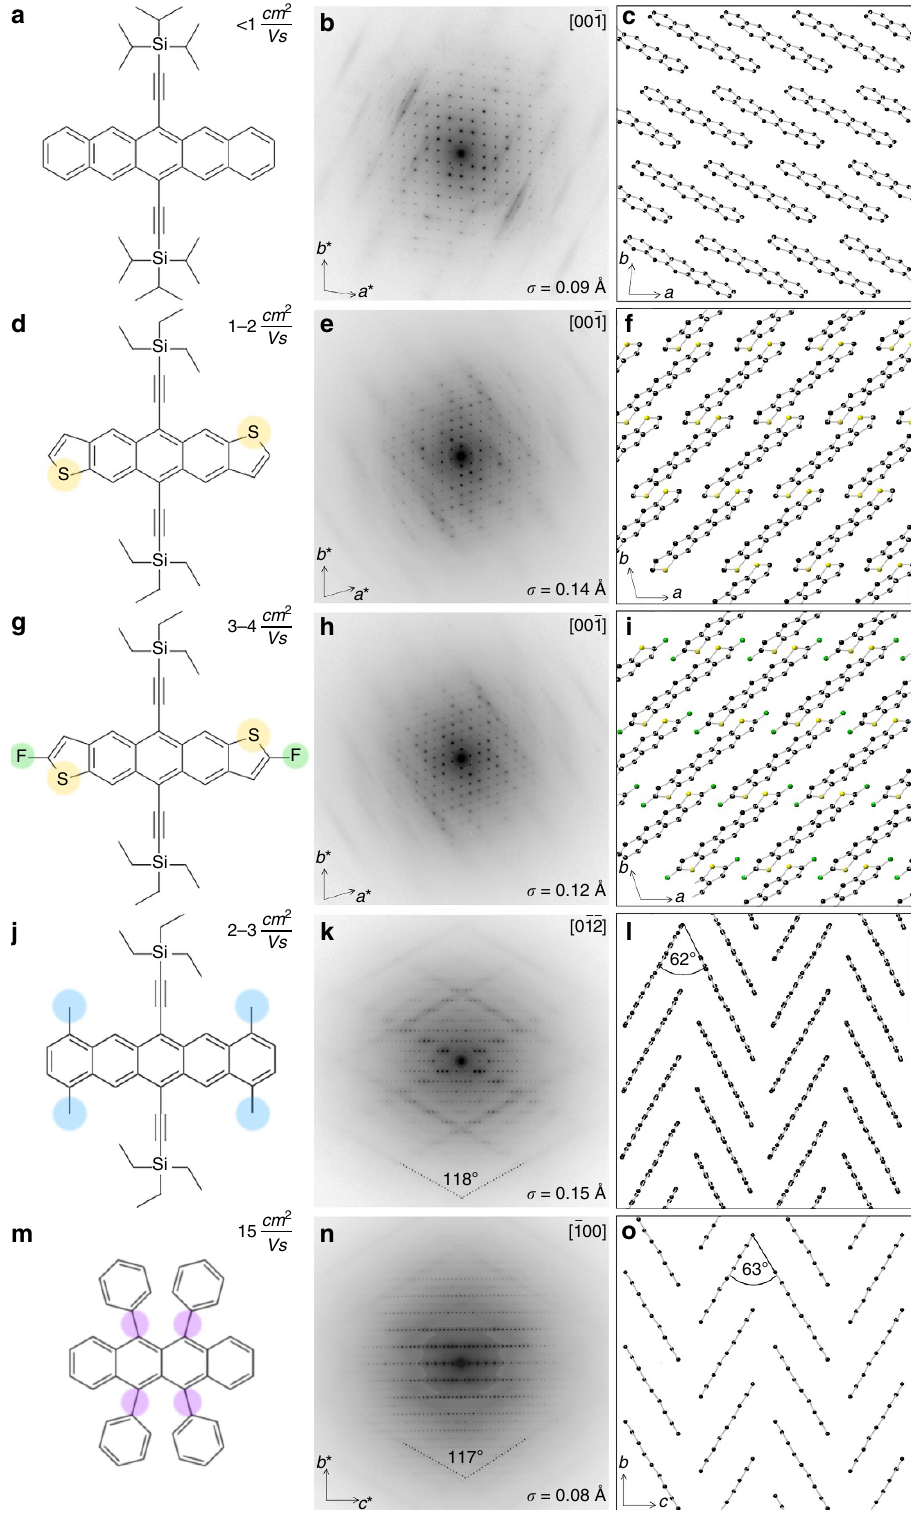
Figure 1 | Molecular structure and electron diffraction pattern with corresponding crystal structure of different molecules. ( a – c ) TIPS-P, ( d – f ) TESADT, ( g – i ) diF-TESADT, ( j – l ) TMTES-P and ( m – o ) rubrene. The presented field-effect mobilities have been measured in single crystals that have been grown in the same condition than those studied by electron diffraction. These values are indicative only for these materials and higher values might be achieved if crystal growth and device fabrication was optimized further. Details are presented in the Supplementary Methods. Diffraction patterns are presented on a logarithmic intensity scale, which makes the faint streaking visible alongside the much stronger Bragg reflections. Refinement against simulated diffraction pattern yielded the amplitudes s of the dominant long-axis vibration at room temperature. Crystal structures are oriented to correspond to the direction of the diffraction pattern. Hydrogens and side chains are omitted for